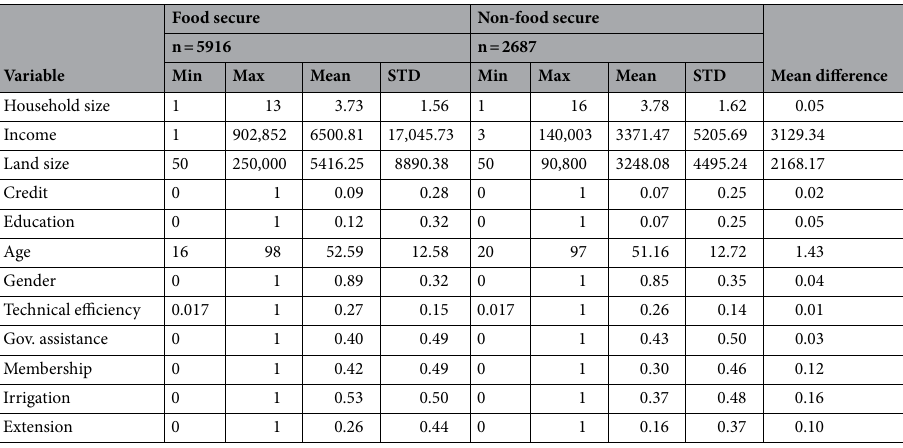
Table 3. Descriptive statistics.